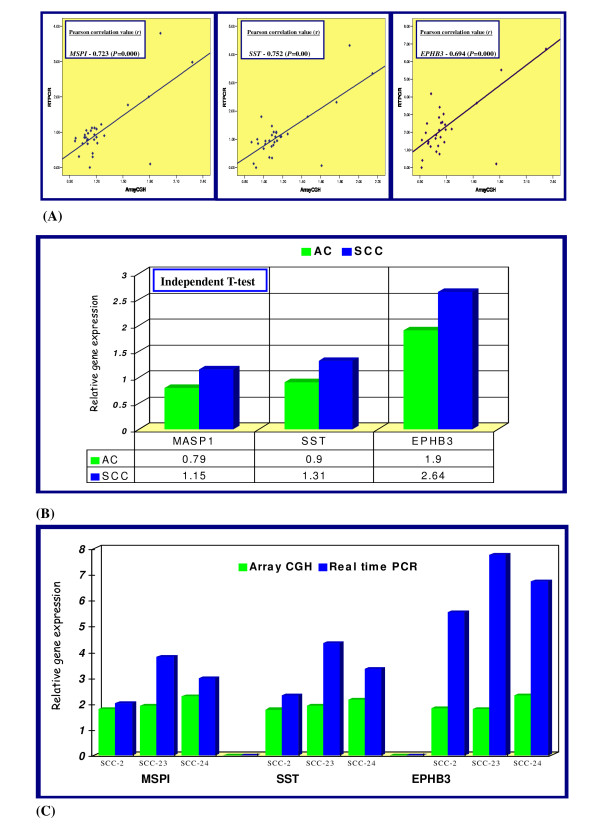
(A) The scatter plot analysis of all data points of three genes (EPHB3, MASP1 and SST) by Array CGH (X axis) and Q-RT-PCR (Y axis) analysis in NSCLC patients. Each dark square, the log2 ratio value of the clone containing one of these genes for one case. The correlation coefficients (r) and P-value are given in the upper left corner of the figure. (B) Comparison of real time PCR analysis of EPHB3, MASP1, or SST between SCCs and ACs. Note that the mean expression levels for selected genes were higher in SCCs compared to ACs. (C) Gene expression levels in Q RT PCR of three genes in three cases seen with amplification at 3q27.1–q27.3 by Array CGH. Each samples are depicted (x-axis) and the fold difference of array CGH was depicted by linear-ratios, and N-value was delineated in real time PCR (y-axis). The heights of the bars represent mean expression level of the indicated genes in each SCC cases.